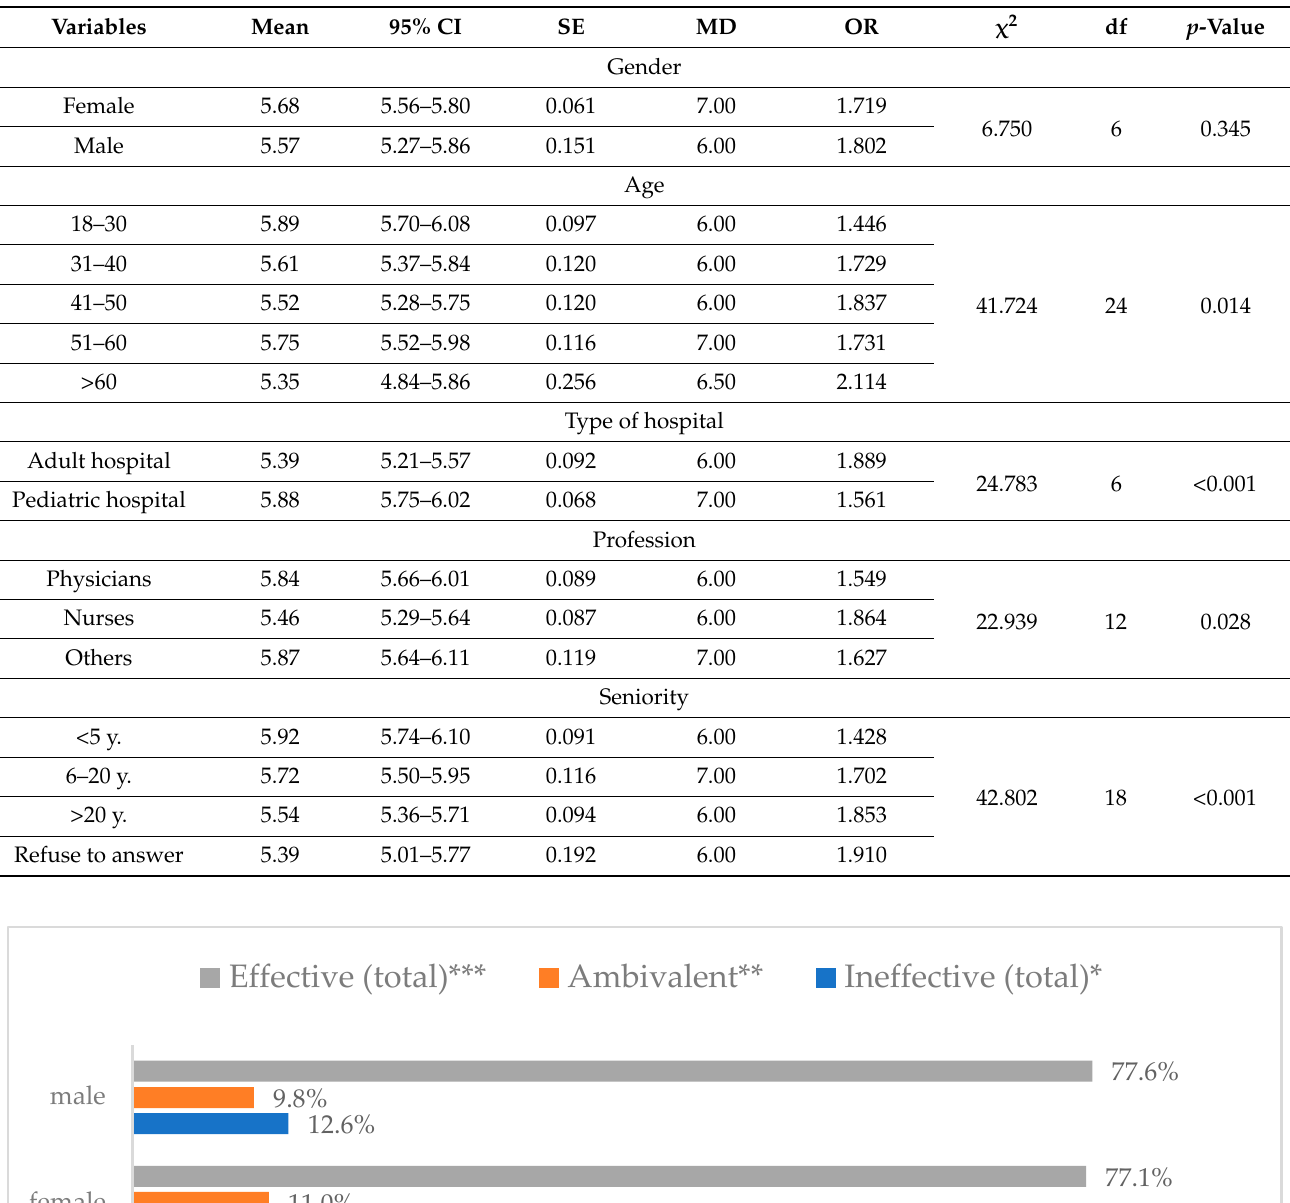
Table 6. Rating of avoiding contact with sick people to prevent influenza virus infection by socio- demographic category ( N = 950).